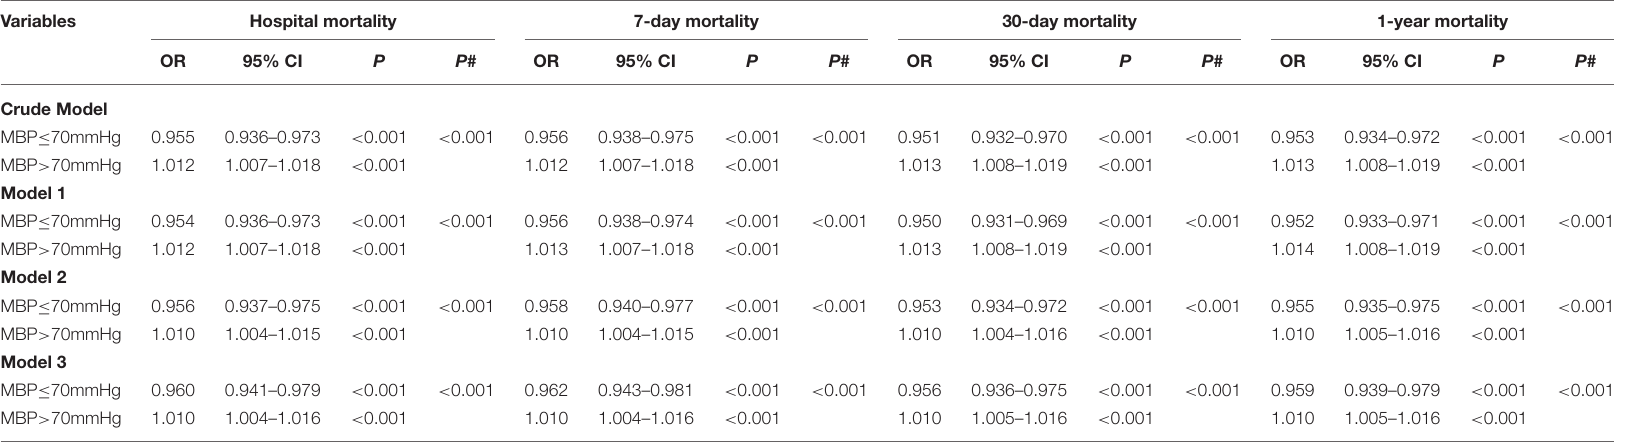
TABLE 3 | Multiple logistic regression analysis for relationship between MBP and mortality risk.